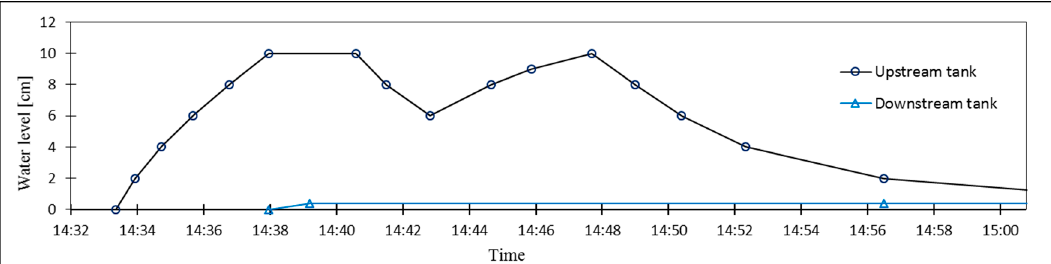
Figure 6. Time dependency of water level at upstream and downstream tanks (left and right boundaries).